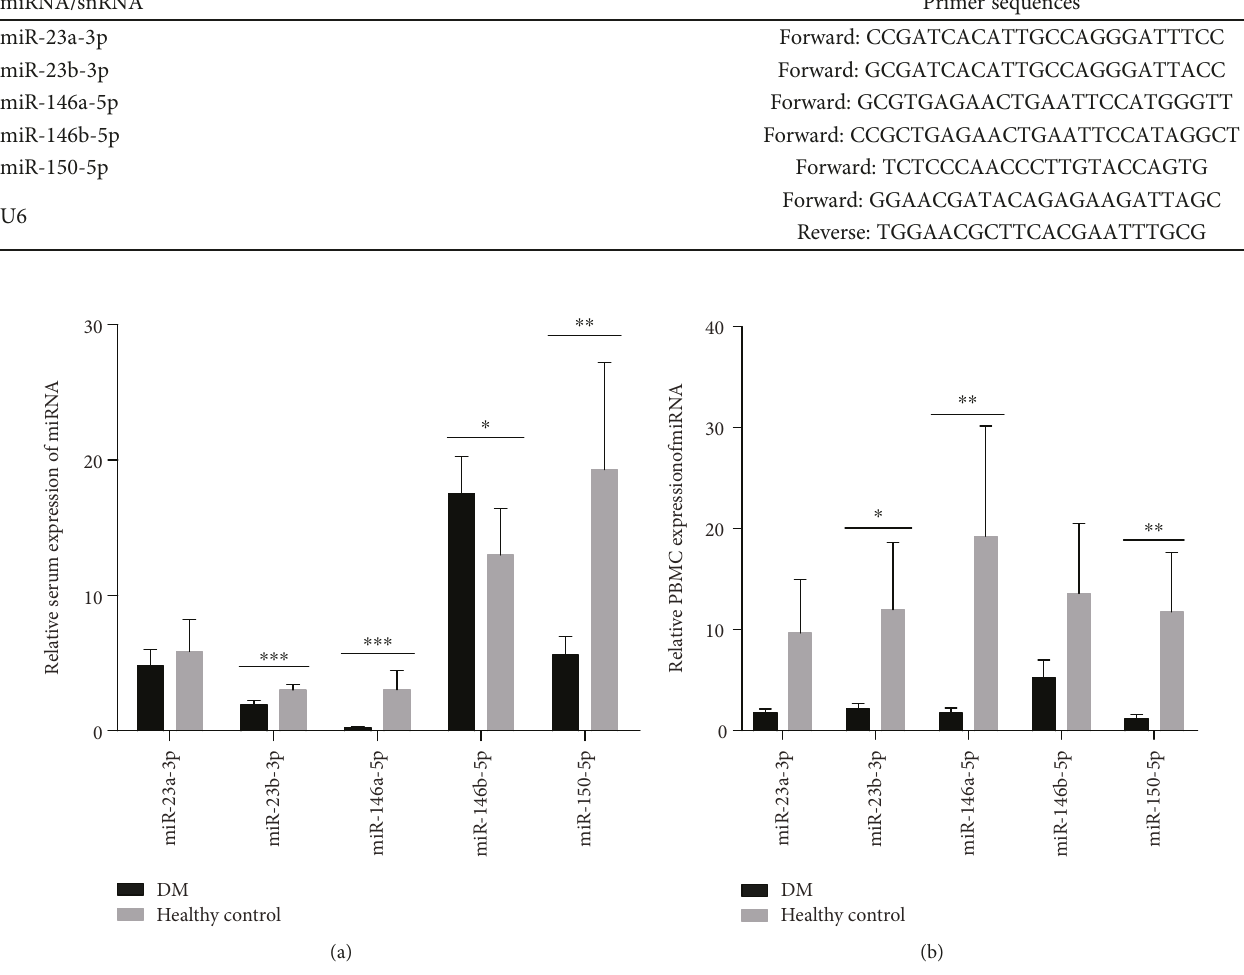
Figure 1: Comparison of the levels of microRNAs (miR-23a-3p, miR-23b-3p, miR-146a-5p, miR-146b-5p, and miR-150-5p) in sera of DM patients and the healthy controls (49 DM and 30 control cases) and in PBMCs between 23 DM patients and 9 healthy controls by quantitative reverse transcription-PCR (qRT-PCR). Values shown were normalized to cel-miR-39-3p. Di ff erences between the levels were expressed as relative expression using the 2 - ΔΔ Ct method. Data were expressed as mean ± standard deviation (SD). 2-group comparisons were analyzed using the Mann-Whitney U test. All P values were two-sided, and P < 0 05 was statistically considered signi fi cant. ∗∗∗ P < 0 001 , ∗∗ P < 0 01 , and ∗ P < 0 05 . miR: